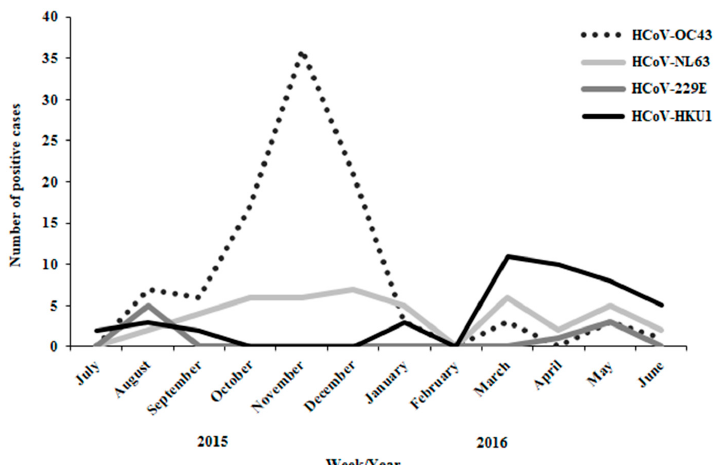
Figure 4. Year distribution of HCoV types in hospitalized patients. Months distribution of 195 hospitalized HCoV-positive cases from July 2015 until June 2016. Each HCoV type is presented as number of positive cases each